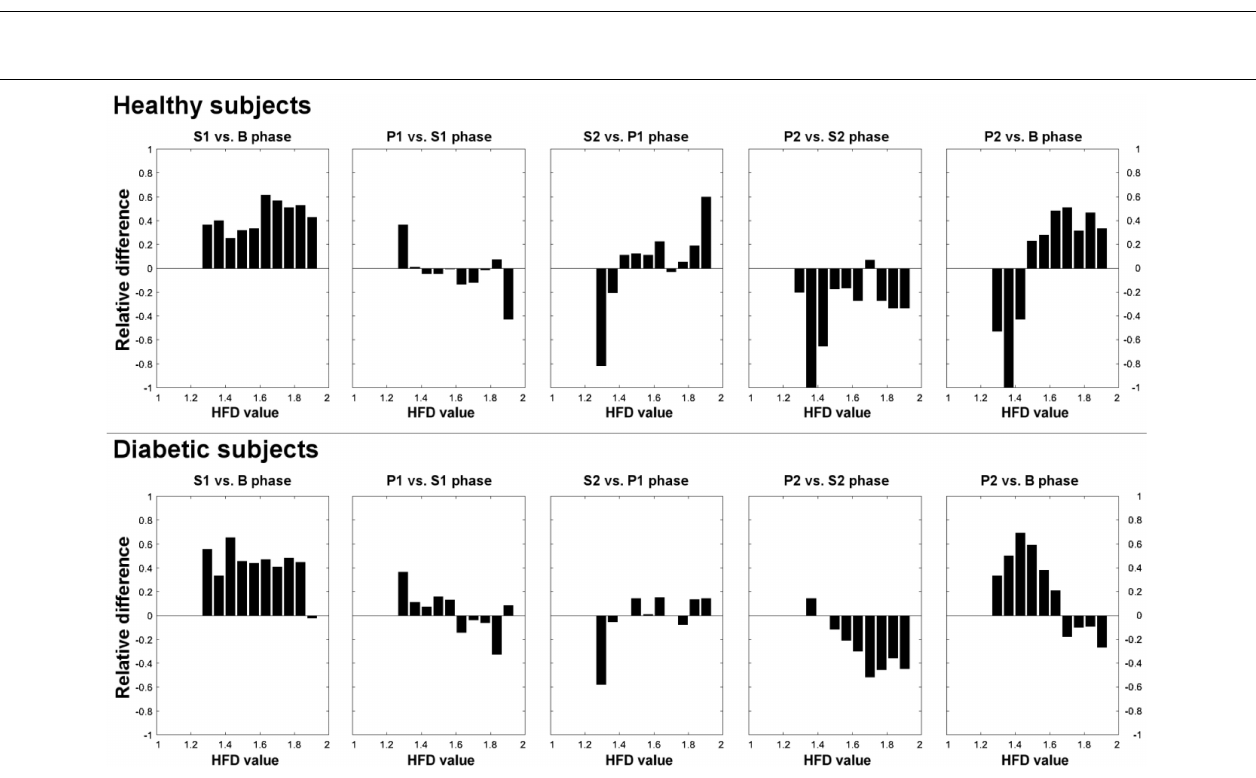
FIGURE 5 | Contrast histograms of HFD distributions for comparison of S1 and B; P1 and S1, S2 and P1, P2 and S2, and P2 and B experimental phases, for healthy and diabetic subjects separately.